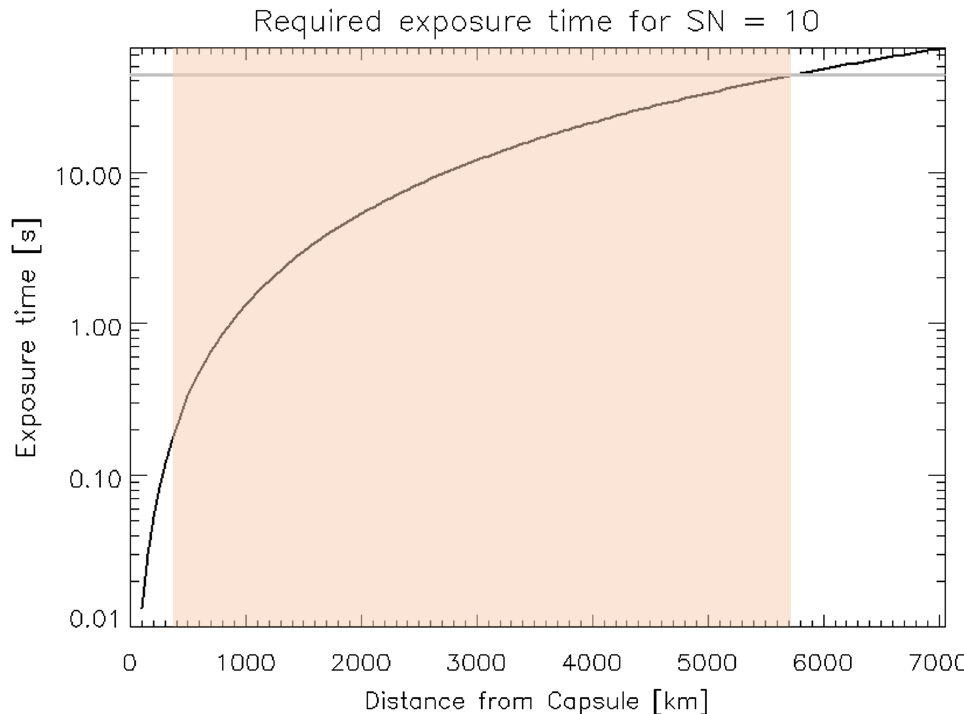
Fig. 15 Required exposure times for observing the return capsule with a S/N ratio of 10 as a function of observation distance. A gray line indicates the maximum exposure time of ONC-W2 (44 s), and the orange colored region indicates conditions in which ONC-W2 is capable of observing the